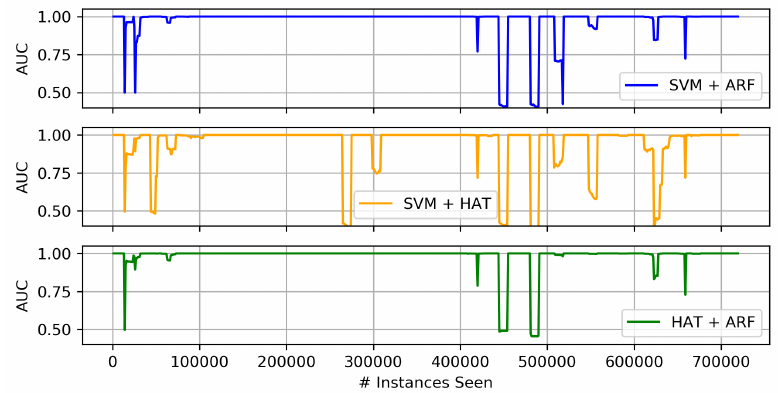
Figure 4. Comparison of heterogeneous ensemble performances on combined dataset.